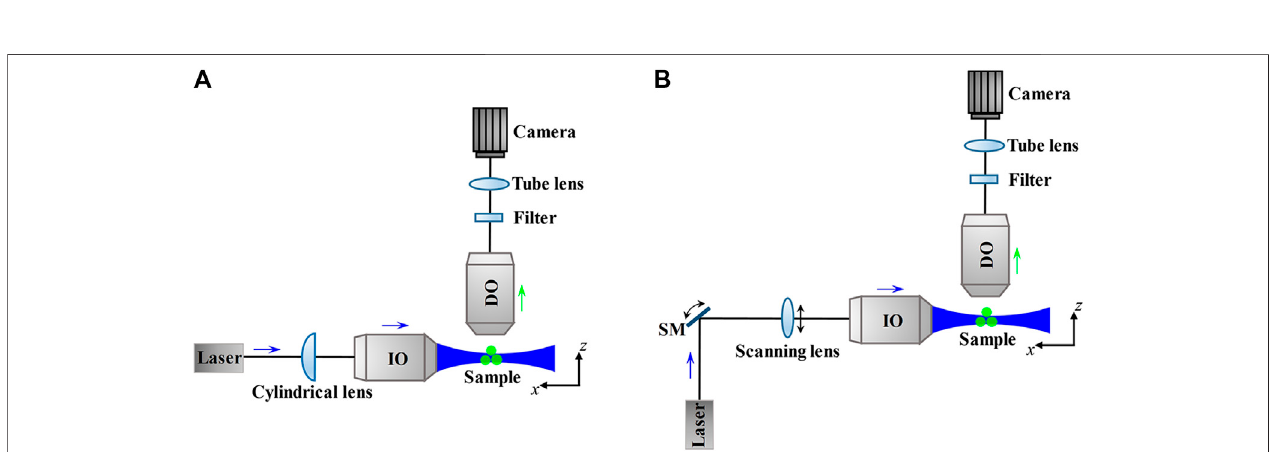
FIGURE 9 | Schematic and principle of dual-lens LSFM. (A) and (B) The thin excitation light sheet produced by a cylindrical lens (A) or a laser scanner (including a scanning mirror and a scanning lens) (B) only illuminate the focal plane of the detection objective lens, which reduces photobleaching and phototoxicity to the sample. The fl uorescence emitted from the sample is through the fi lter and tube lens and then detected by the camera. Blue and green arrows indicate the directions of the excitation beam and fl uorescence. SM, scanning mirror; IO, illumination objective lens; DO, detection objective lens.